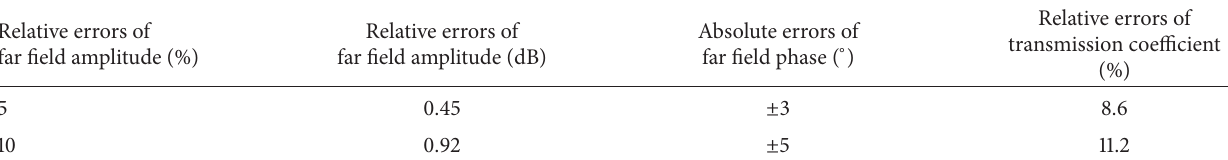
Table 9: Influence of far field data’s error on the transmission coefficient.